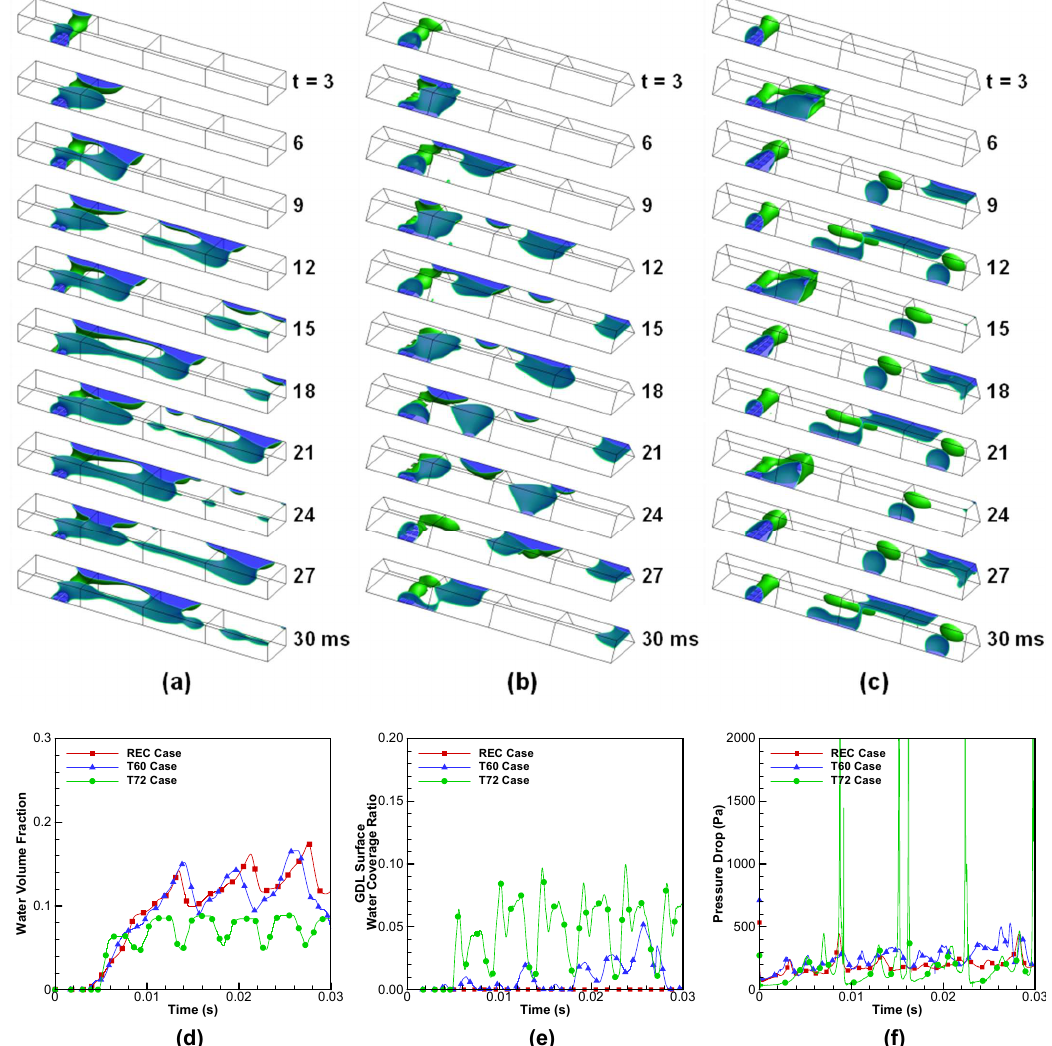
Figure 2. Time evolution of the gas-liquid interface, water volume fraction (WVF), water coverage ratio of the GDL surface (GWCR), and pressure drop in the GCs ( V in , air = 5.0 m · s − 1 , V in , water = 0.1 m · s − 1 , θ ts = 60 ◦ , θ g = 130 ◦ , H12 water inlet configuration): ( a ) gas-liquid interface (REC); ( b ) gas-liquid interface (T60); ( c ) gas-liquid interface (T72); ( d ) WVF; ( e ) GWCR; ( f ) pressure drop between inlet and